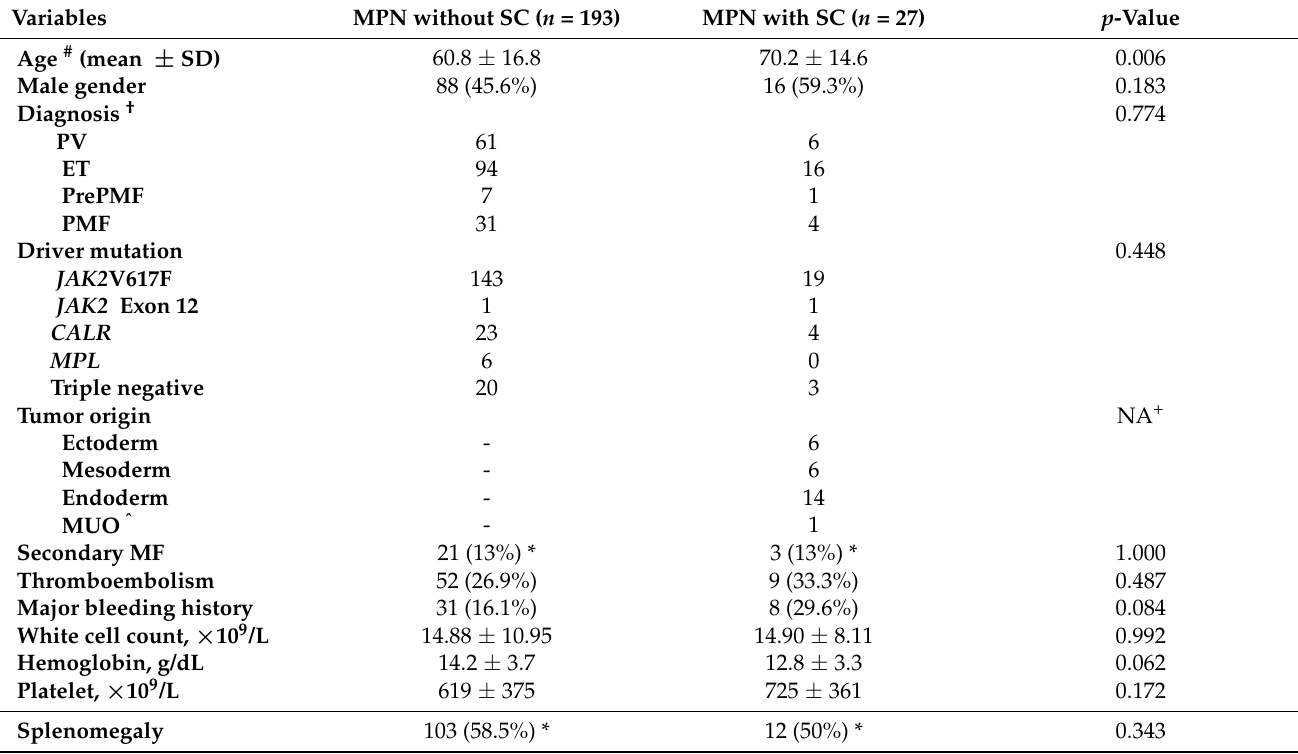
Table 1. Baseline characteristics of MPN